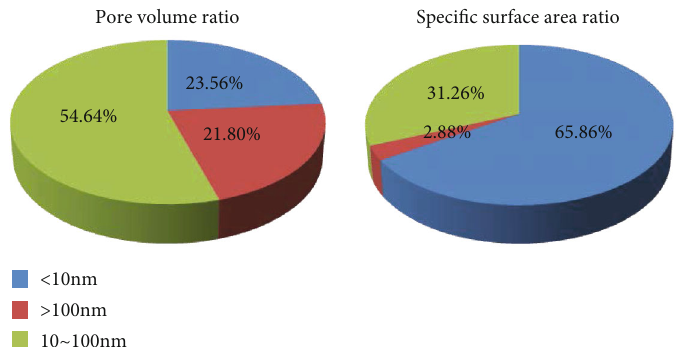
Figure 11: Figure of average proportion of speci fi c surface area and pore volume of coal